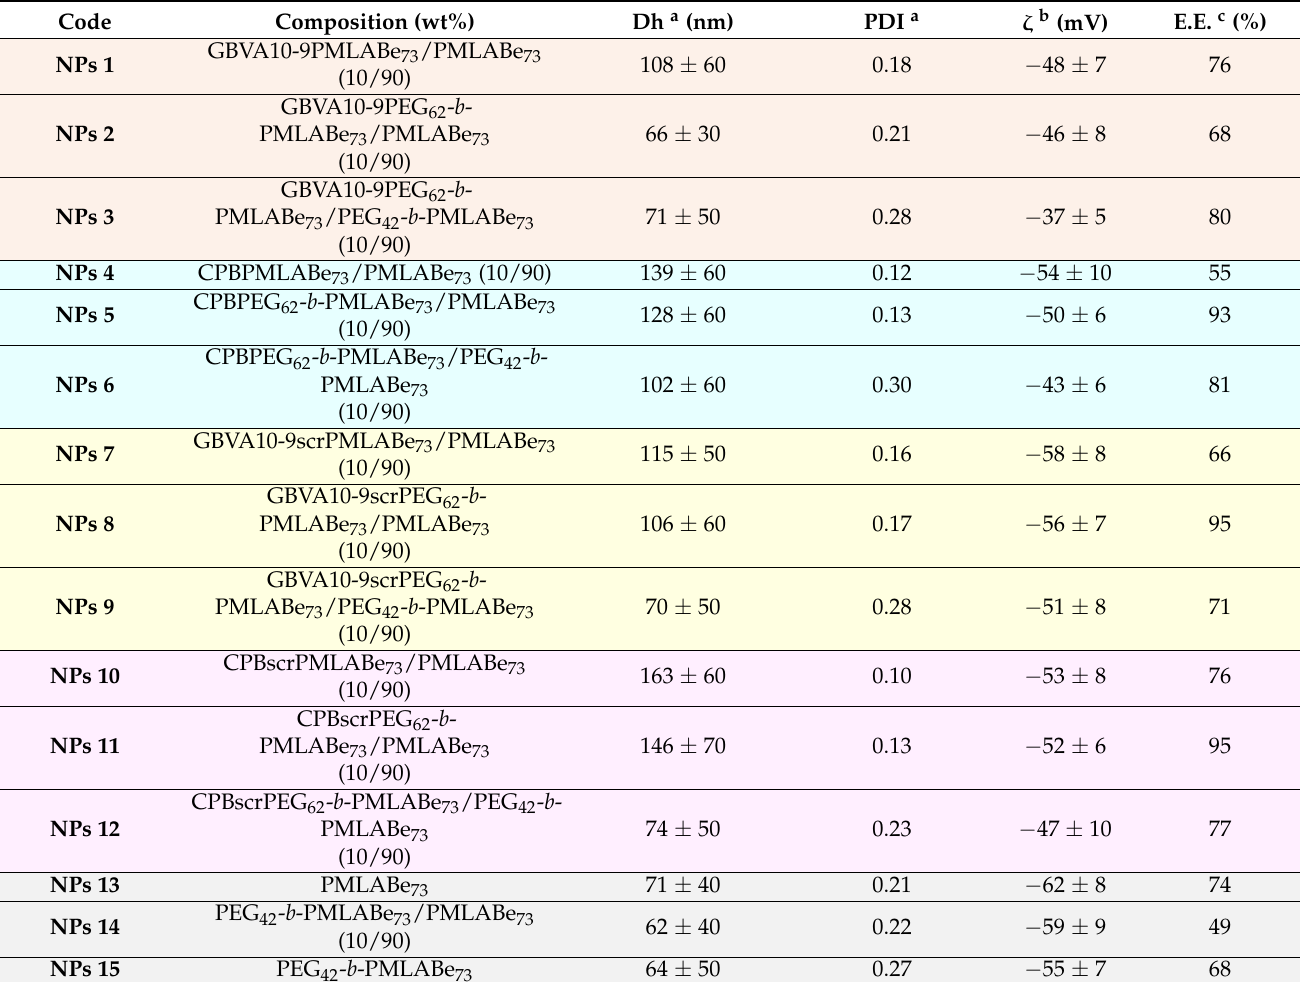
Table 5. Characteristics of peptide-decorated and native